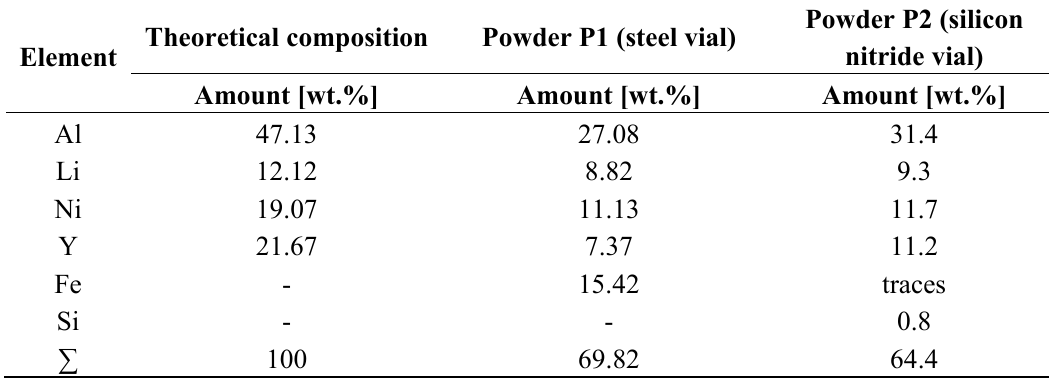
Table 1. Chemical composition of amorphous and annealed Al the amount of elements in wt.% cannot be summarized to 100%, it is not possible to give the amount in at.%. The standard deviation is 0.3